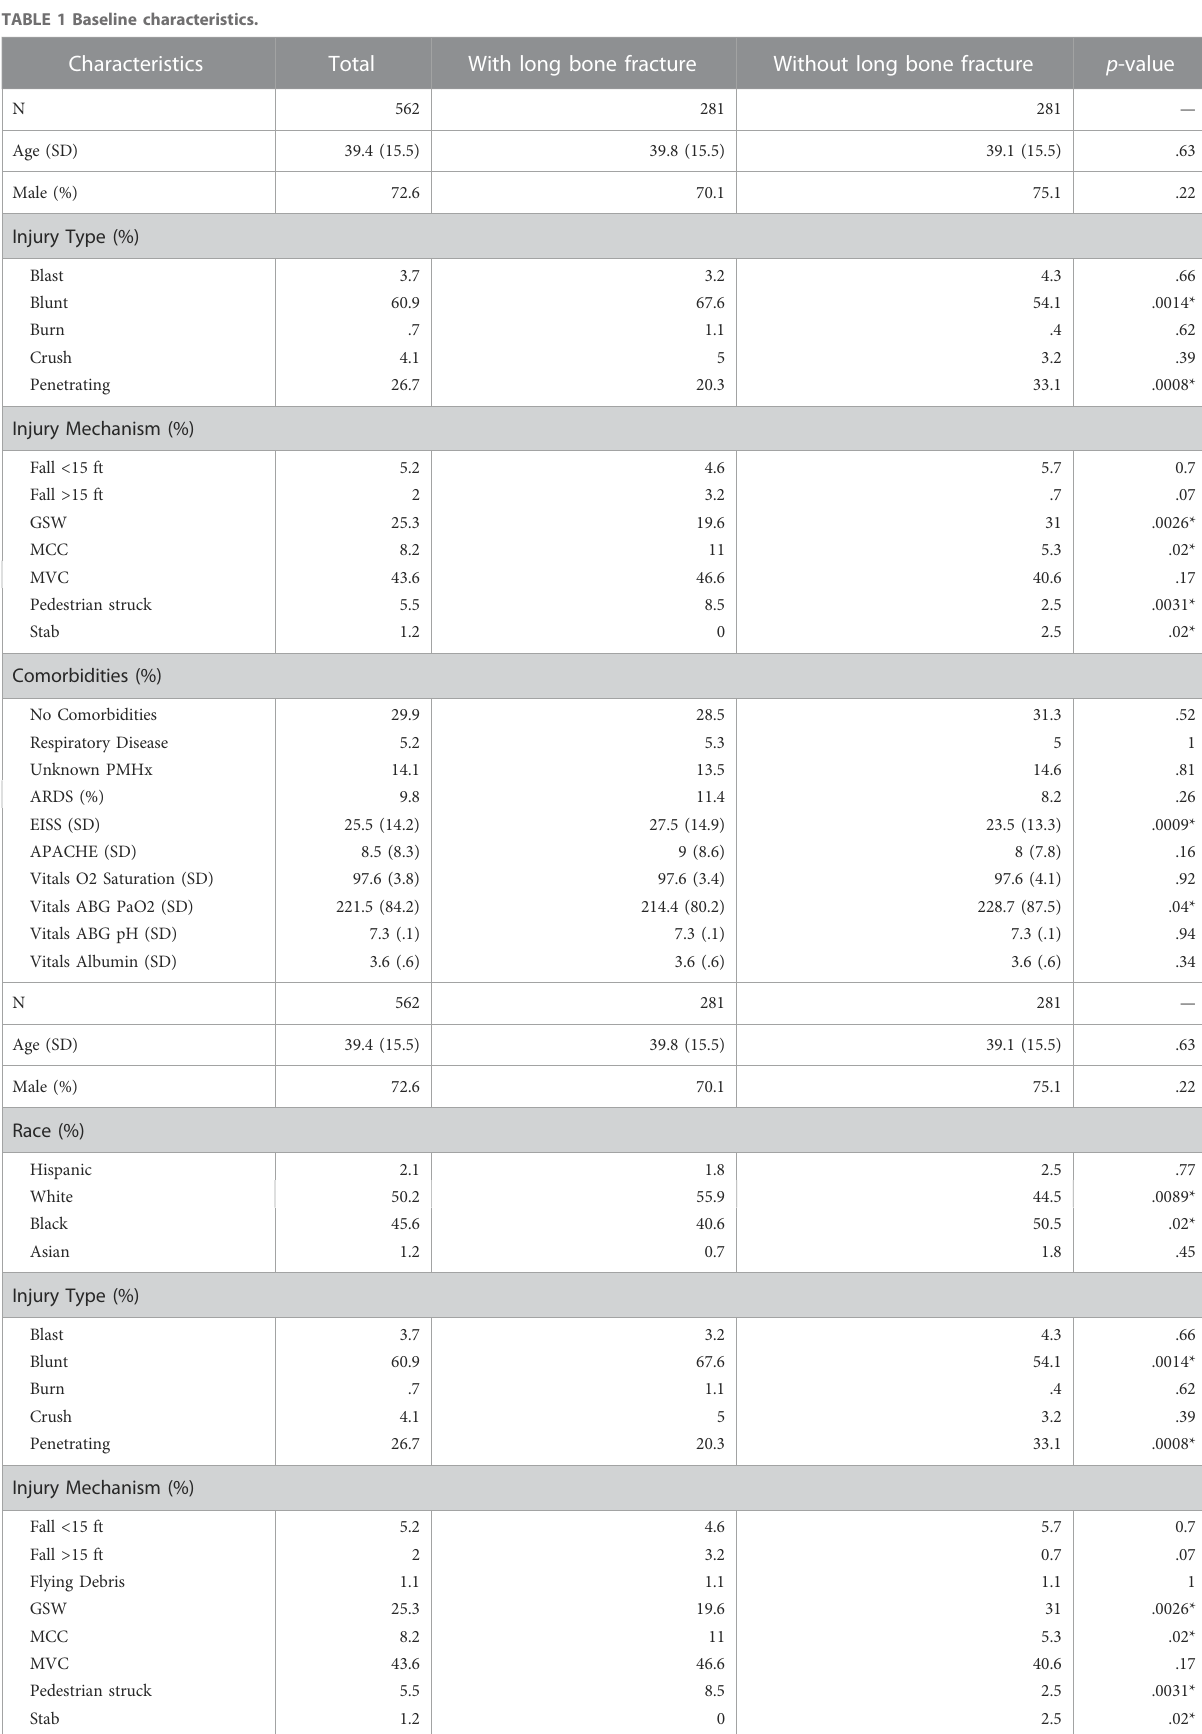
TABLE 1 Baseline